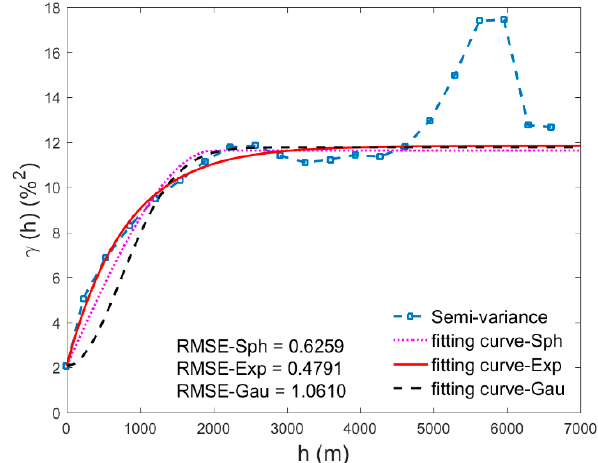
Figure 4. Semivariance of sampled soil moisture data and the fitting curves of the soil moisture semivariogram: the semivariance was calculated by the 9000 random sampling points from the soil moisture map; the semivariogram was fitted by the Spherical model, Exponential model, and Gaussian model, with the data of h ≤ 4000 m, and the range was set as 2400 m.